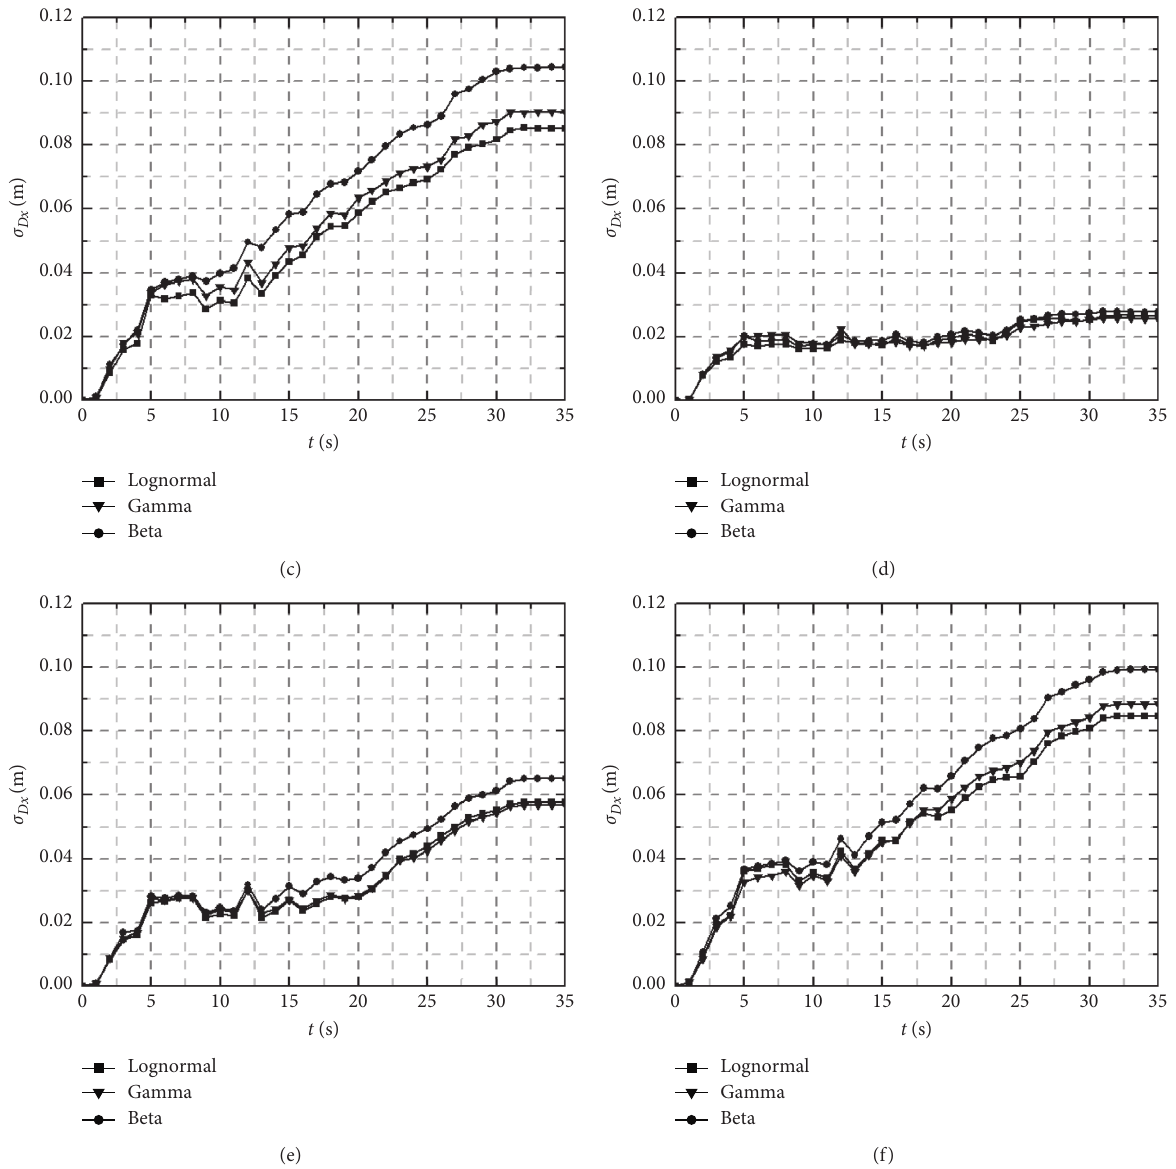
Figure 5: Time history curve of standard deviation of ground horizontal displacement ( μ CoV G � 0.1; (b) δ x � 6 m and CoV G � 0.3; (c) δ x � 6m and CoV G � 0.5; (d) δ x � 60 m and CoV G � 0.1; (e) δ x � 60m and CoV G � 0.3; (f) δ x � 60 m and CoV G �